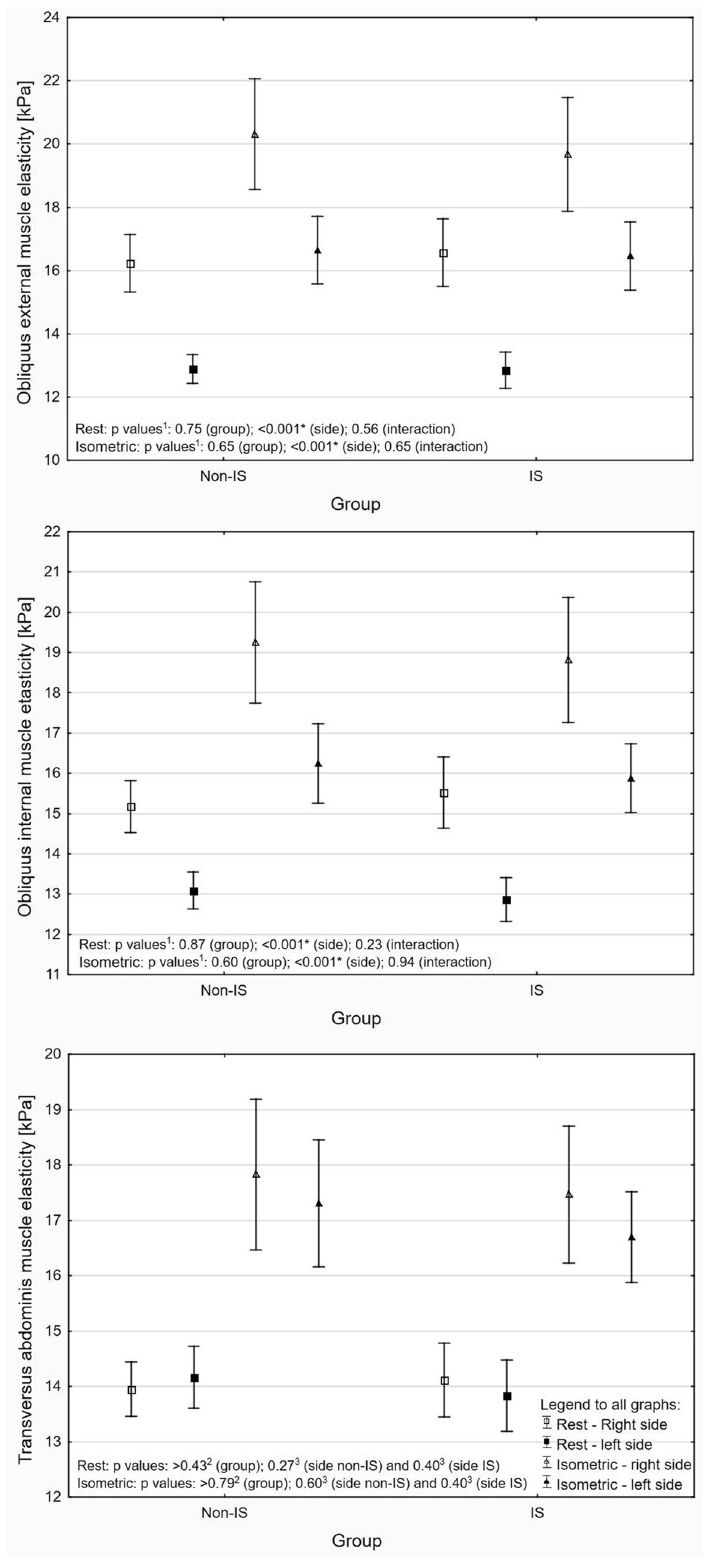
Figure 2. Shear modulus (elasticity) at rest and during isometric contraction in control and idiopathic scoliosis groups with p values from ANOVA 1 , Mann–Whitney U 2 test or Wilcoxon test 3 (*significant